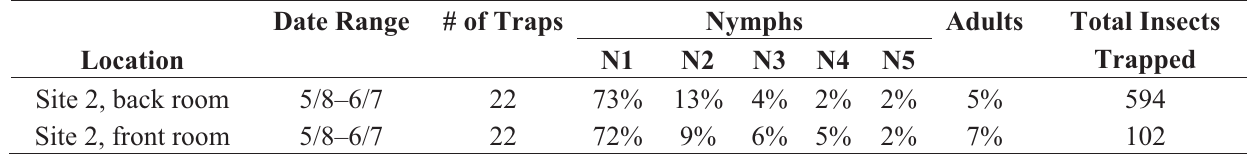
Table 2. Proportion of life stages trapped in two bedrooms at Study Site